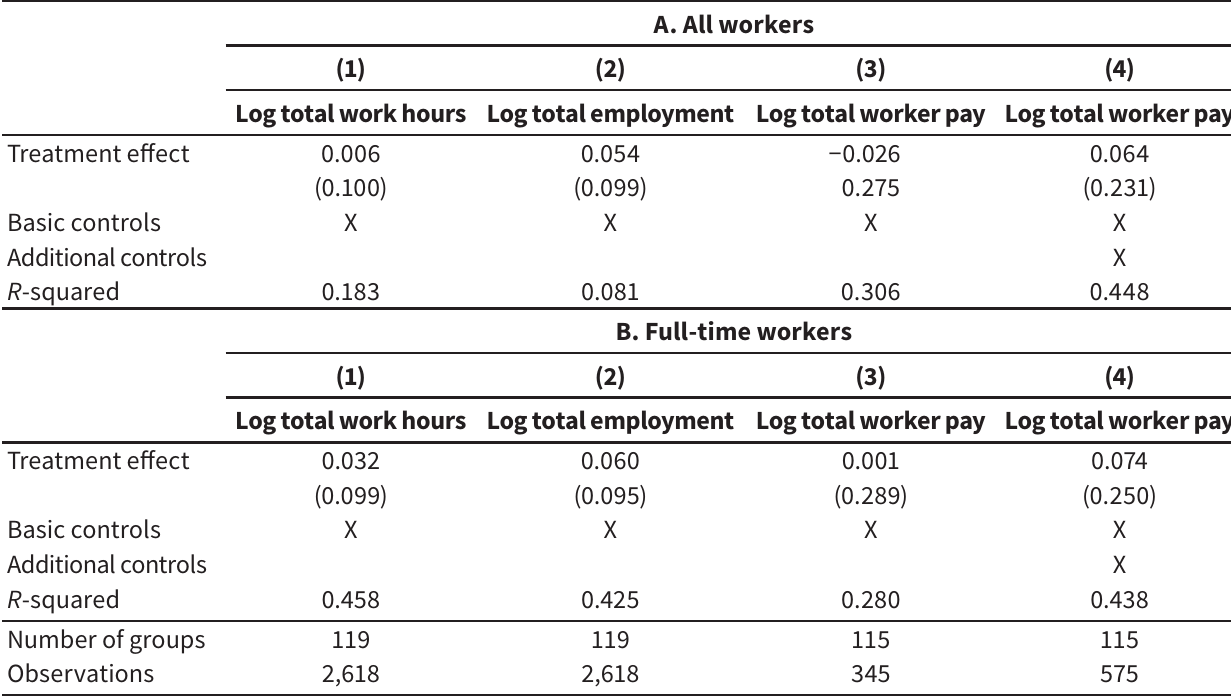
Pre-trend tests for group-level